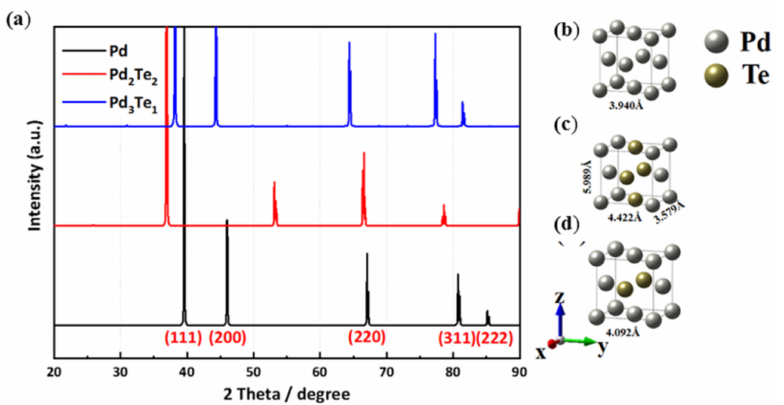
Figure 9. ( a ) Theoretically calculated X-ray diffraction patterns corresponding to ( b ) Pd, ( c ) Pd 2 Te 2 , and ( d ) Pd 3 Te 1 (bulk